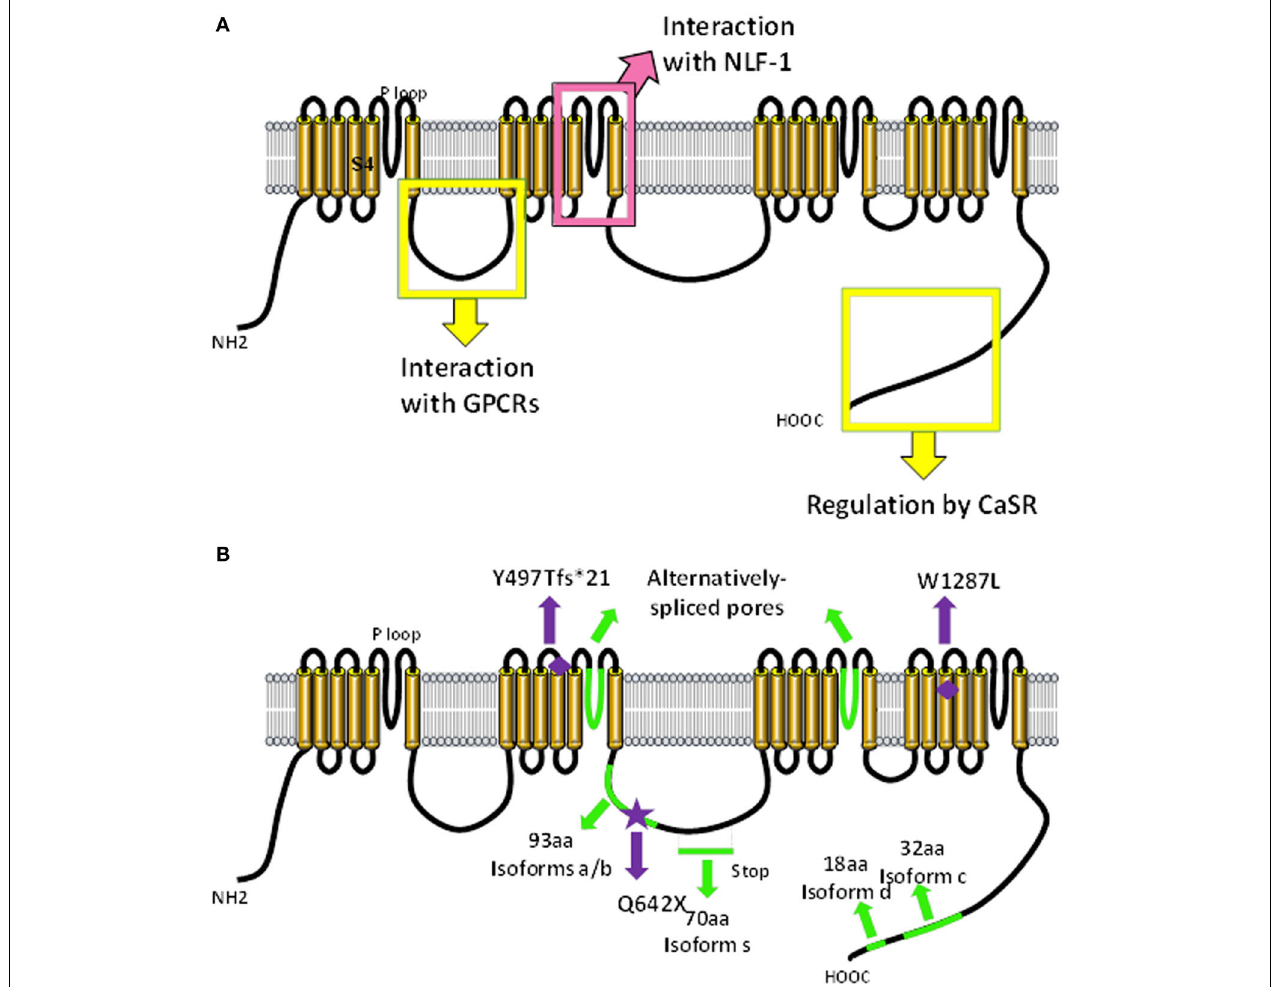
FIGURE 1 | Predicted molecular make-up of NALCN. The predicted structure of NALCN is similar to α / α 1 subunits of voltage-gated Na + and Ca 2 + channels (Lee et al., 1999). (A) It has four homologs repeats (domains I–IV) each composed of six transmembrane segments (S1–6). Four pore-forming loops (P-loops) spanning from S5 to S6 make up the ion selectivity filter. The intracellular loop linking domains I and II of NALCN interacts with M3R and molecular determinants involved in the regulation by CaSR are located in the carboxy-terminus (Swayne et al.,